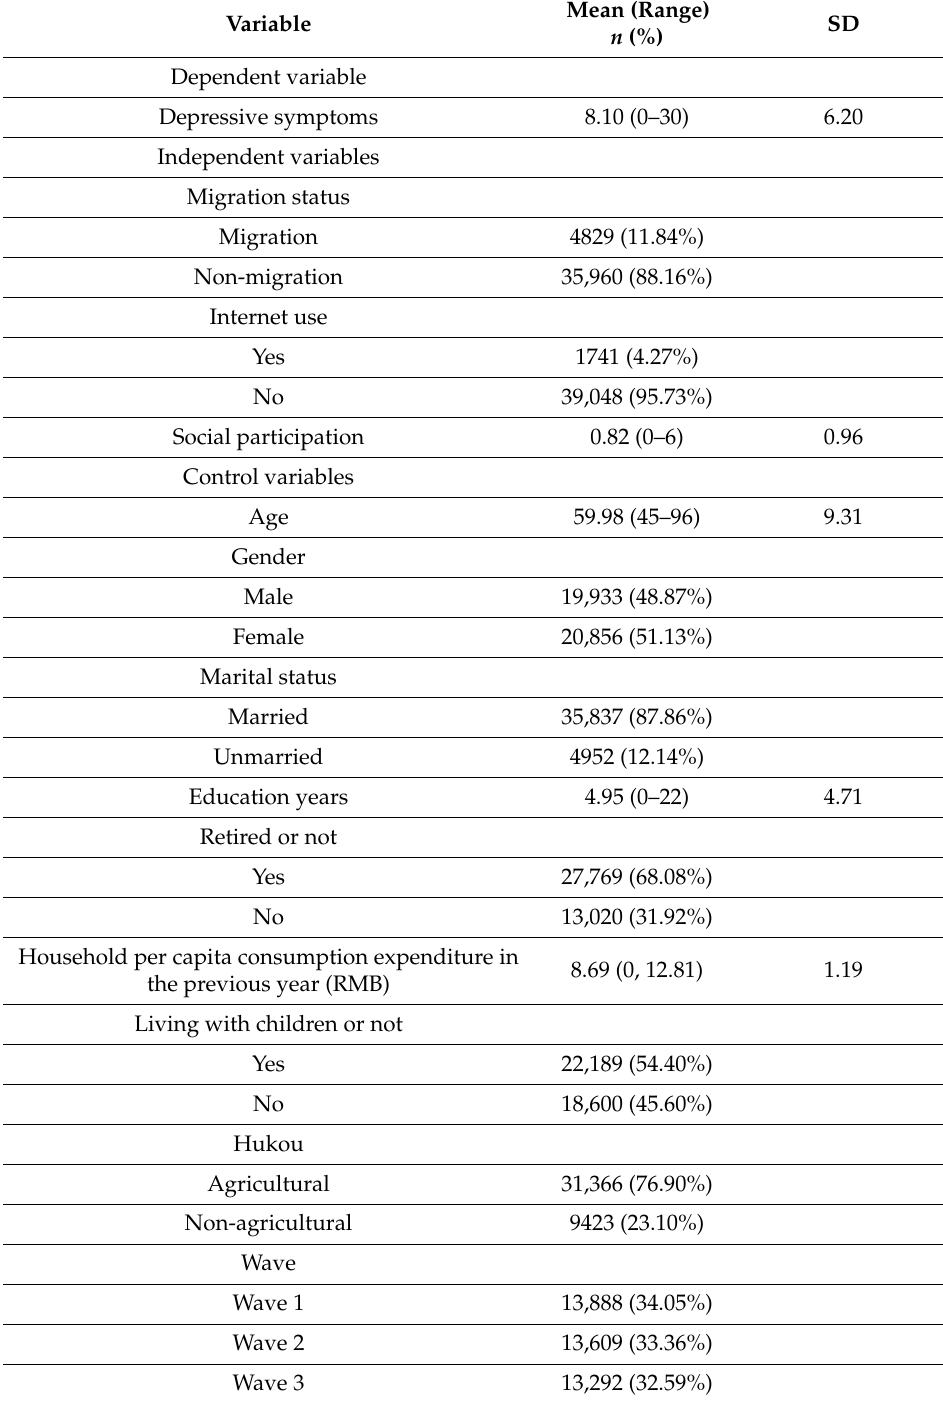
Table 1. Description of Analytic Variables ( n old adults = 18,511, n observations =